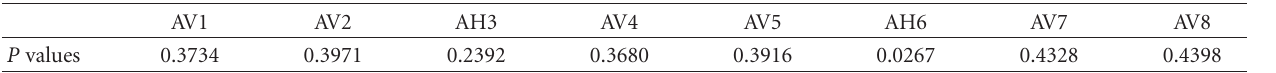
Table 2: P values for comparison of peak acceleration distributions.